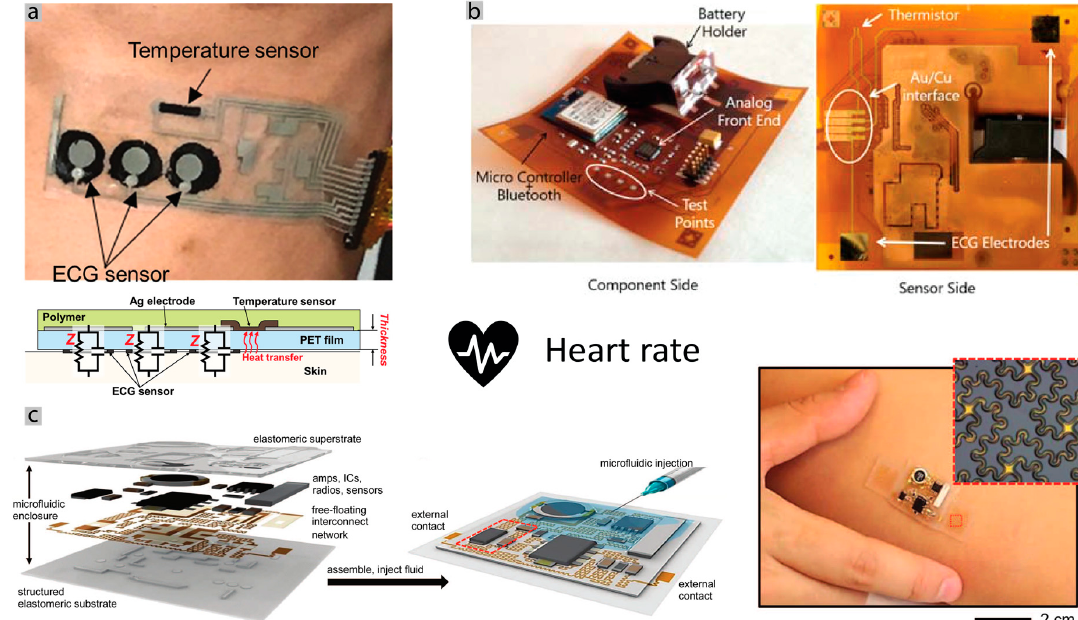
Figure 9. Examples of sensors used for ECG and heart rate monitoring. ( a ) ECG and temperature sensor solution based on stretchable PDMS with PEIE making gel-less electrodes. Adapted with permission from [174]. ( b ) Flexible ECG board with inkjet-printed electrodes on a Kapton substrate. Adapted with permission from [175]. ( c ) ECG sensor solution based on free-floating rigid interconnects in serpentine shape, inside of a microfluidic enclosure. Adapted with permission from [176].